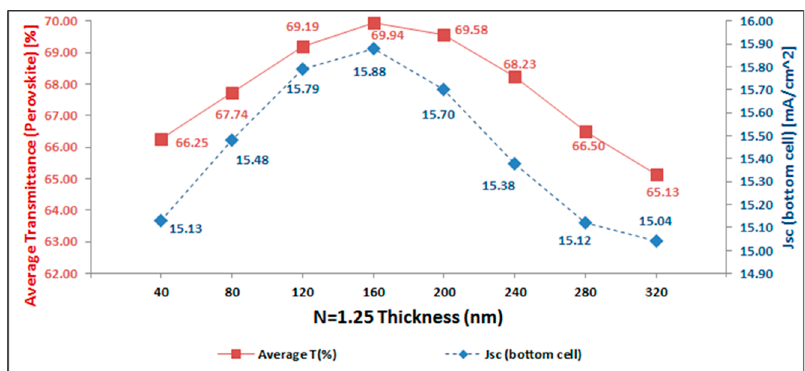
Figure 4. Optical transmission of top sub-cell based on semi-transparent perovskite solar cells (red) and short-circuit current of interdigitated back contact crystalline Si (IBC c-Si) bottom sub-cell are shown.